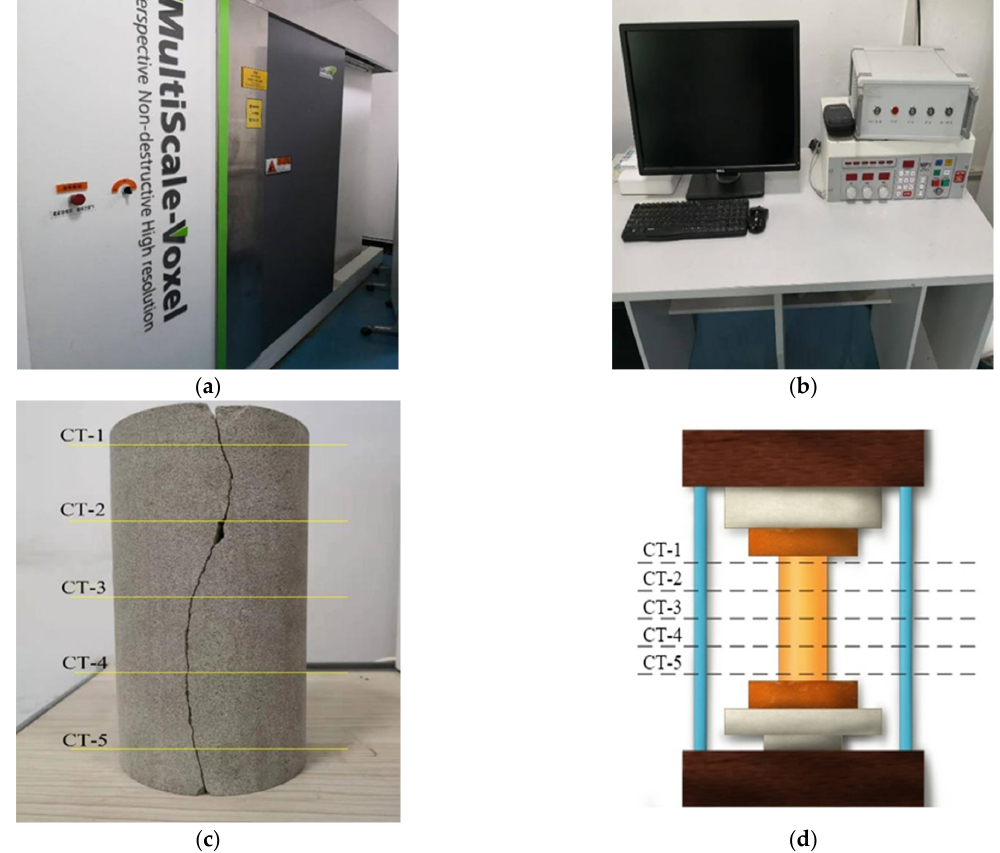
Figure 1. Laboratory CT-scan samples and equipment: ( a ) laboratory CT scanning machine; ( b ) laboratory CT-scan control computer; ( c ) laboratory CT-scan sample; ( d ) cross-sectional stratification of laboratory CT-scan specimens.